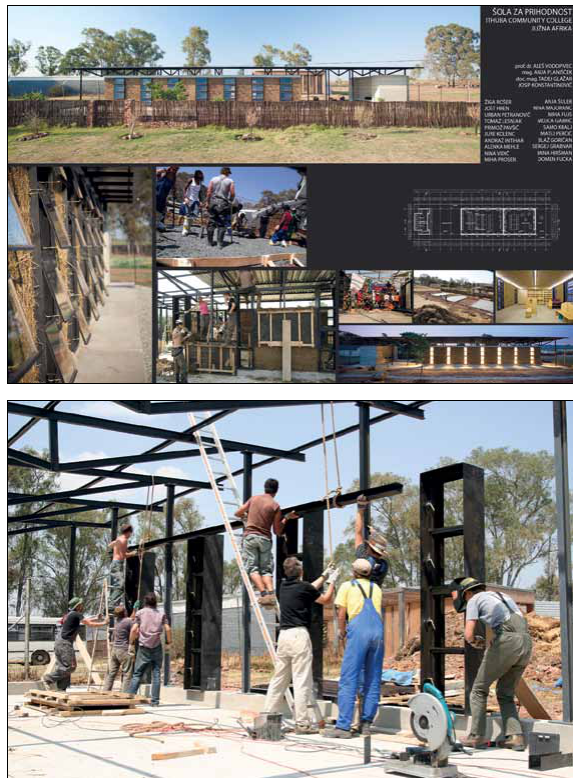
fig. 1. a school for the future. Ithuba community college South africa. Source: Vodopivec et al .